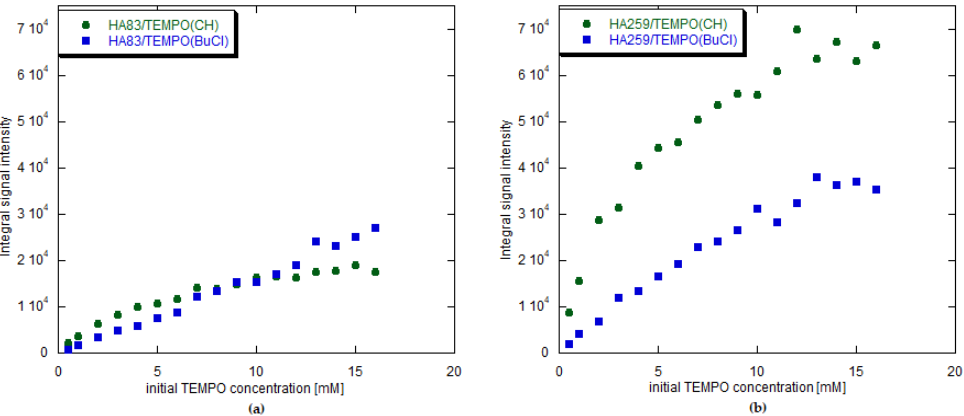
Figure 7. Relationships between the initial TEMPO concentration and the EPR signal integral intensity: ( a ) for HA83/TEMPO composites; ( b ) for HA259/TEMPO composites.